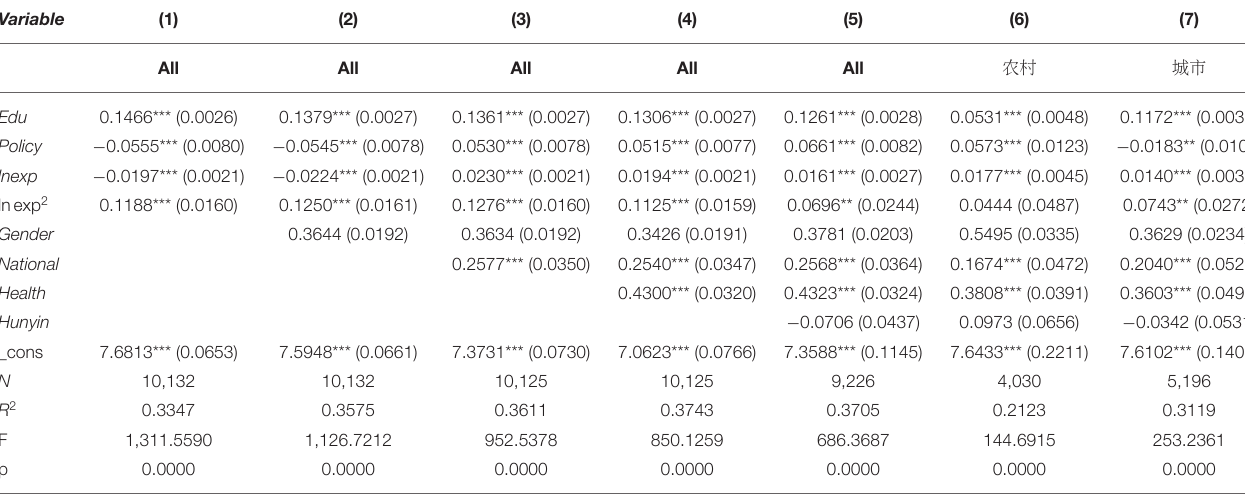
TABLE 4 | Educational returns estimated by OLS.